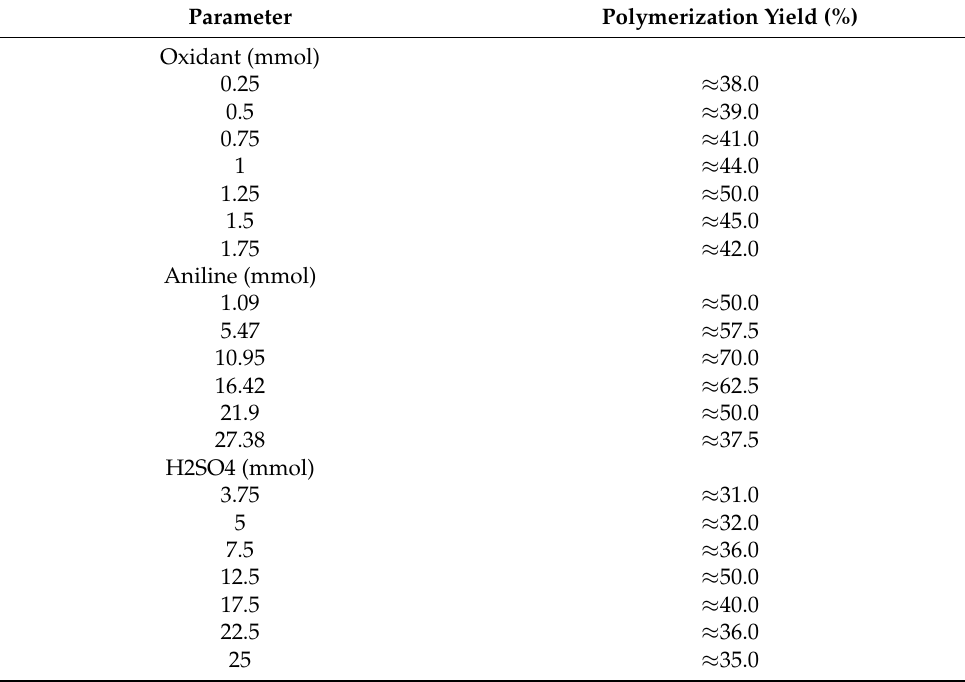
Table 5. The influence of synthesis parameters on the percent yield of PANi–DBSA–H 2 SO 4 salts [92].